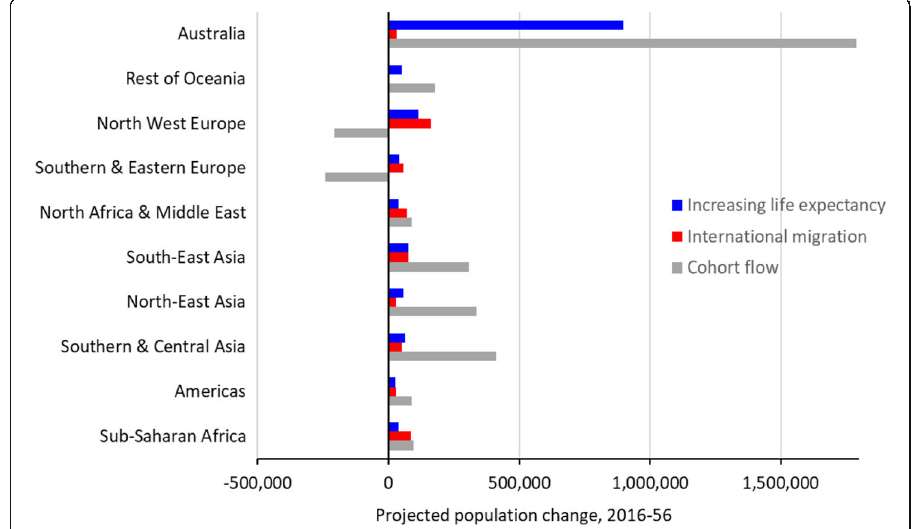
Fig. 3 The demographic drivers of population change at ages 65+ by broad birthplace category, 2016- 2056. Source: authors ’